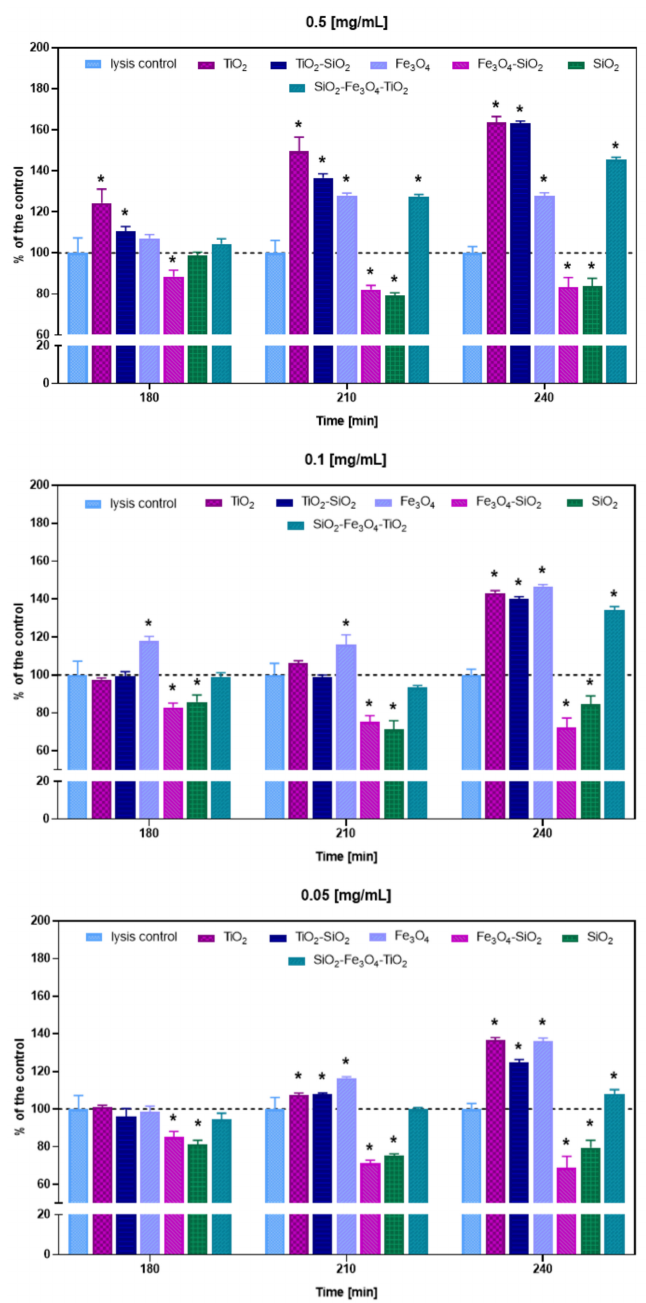
Figure 3. Area under the curve analysis of phage T4 5 infection in the presence of nanoparticles at different concentrations (0.5, 0.1 and 0.05 mg/mL), at 180, 210 and 240 min of infection, as derived from lysis profile experiments equivalent to those presented in Supplementary Material (Figure S3). The smaller the area under a lysis profile curve, the greater the reductions in culture turbidity over time— better phage lysis performance. Percent above the dashed lines indicate higher optical density (OD) drops/greater reductions in culture turbidity compared to the control/better phage lysis. Percent below the dashed lines indicate lower OD drops/smaller reductions in culture turbidity compared to the control/weaker phage lysis. Error bars represent standard deviation between samples. Means sharing the star asterisk are significantly different from each other at p ≤